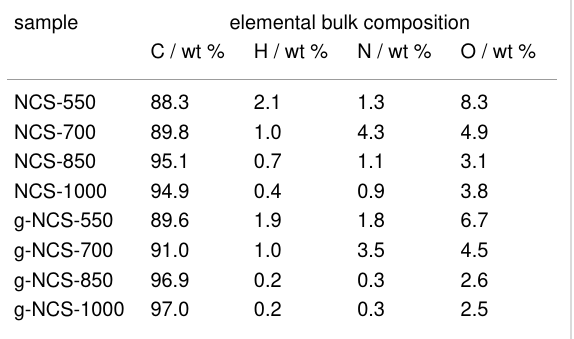
Table 1: Elemental bulk composition determined by CHN analyses (supported by SEM/EDX measurements). sample